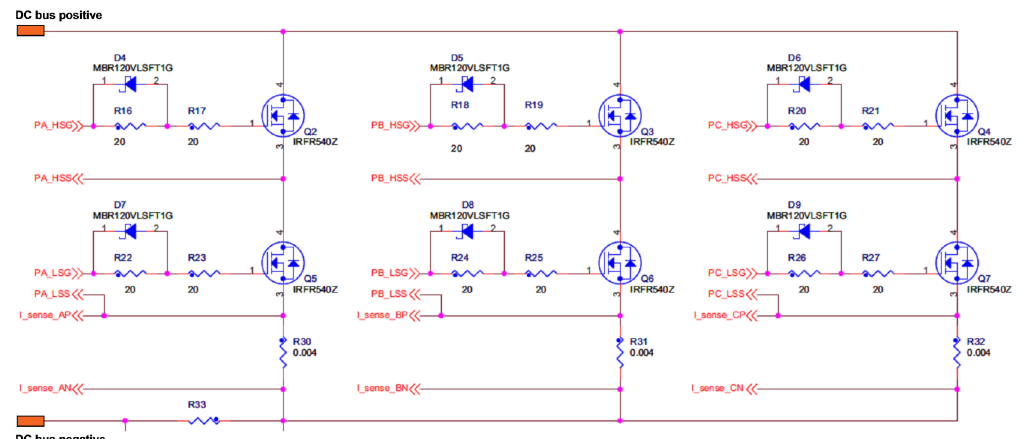
Figure 7. NXP three-phase low voltage power inverter with shunt resistors for current measurement [32].